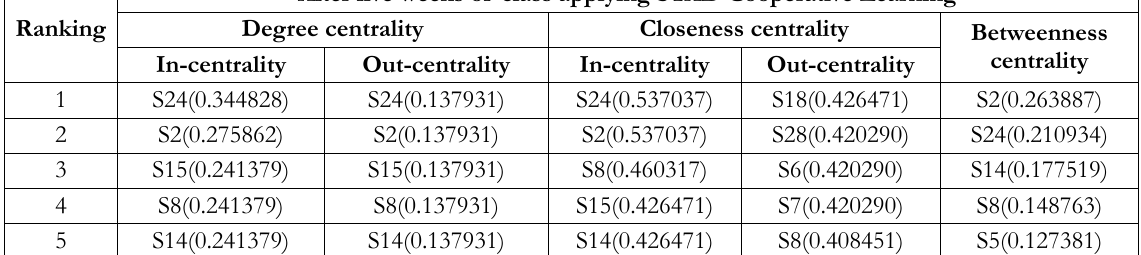
Table 8. Top Ranked Student by Central Indicators